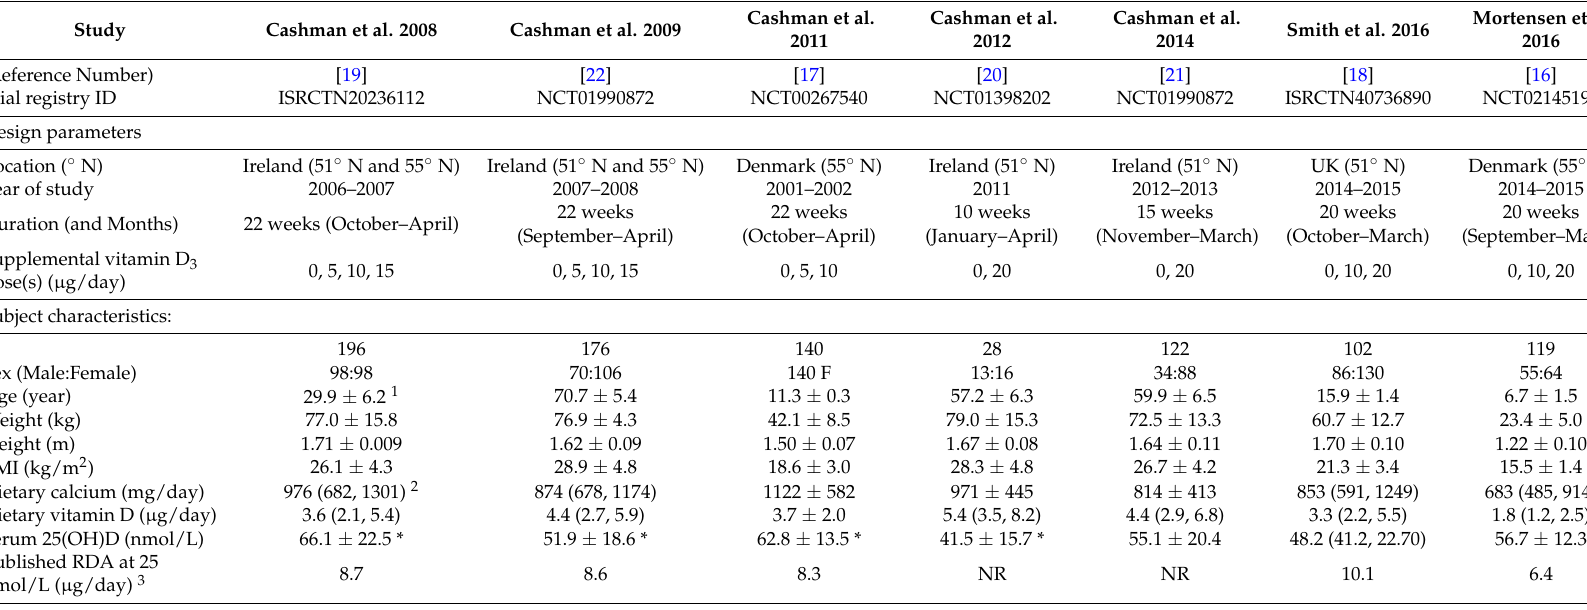
Table 1. Selected design parameters of the seven winter-based, North European (>50 ◦ N) vitamin D randomized controlled trials and baseline characteristics of subjects who completed the intervention studies and were included in data